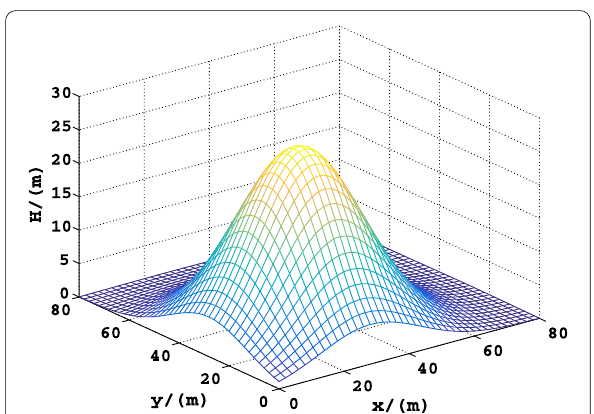
Fig. 6 DTM model without random errors in the third example